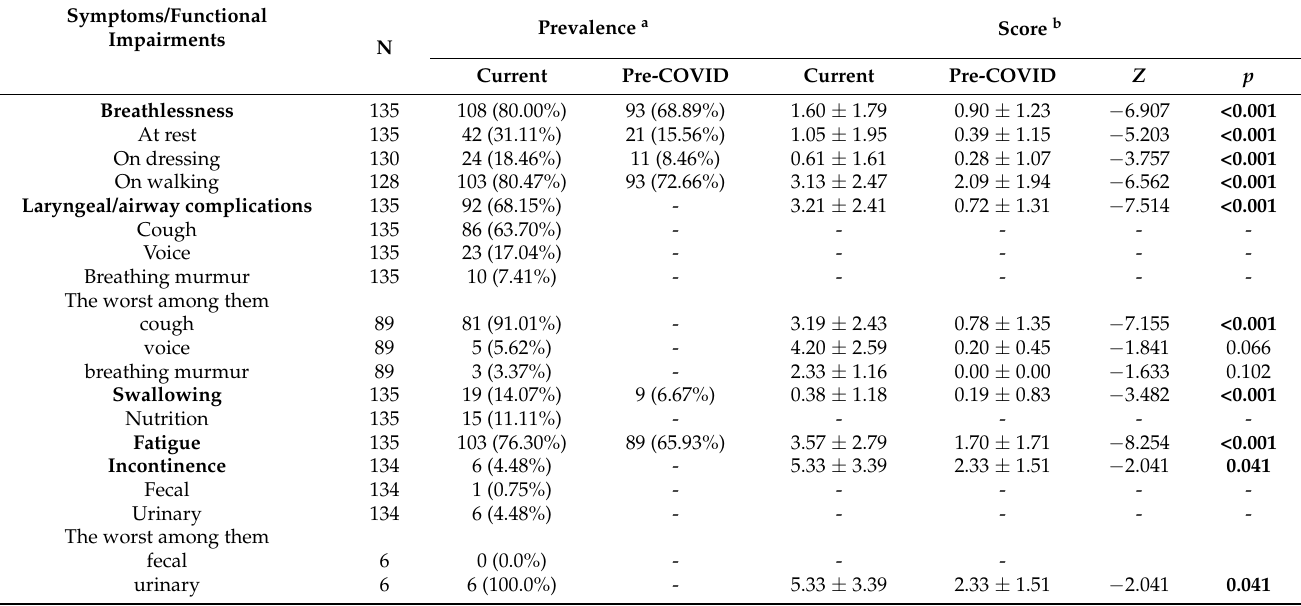
Table 2. Prevalence and scores of symptoms, functional difficulties, and overall health as measured using